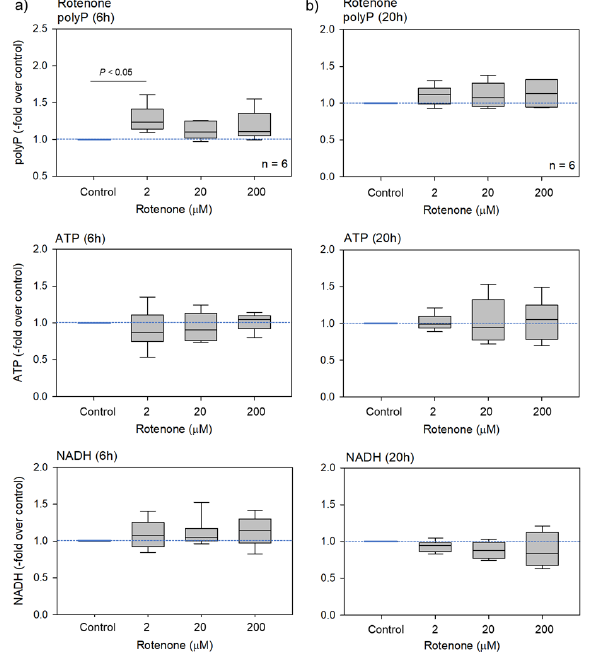
Figure 3. The effects of rotenone on platelet polyP, ATP, and NADH levels after 6 h ( a ) or 20 h ( b ) of